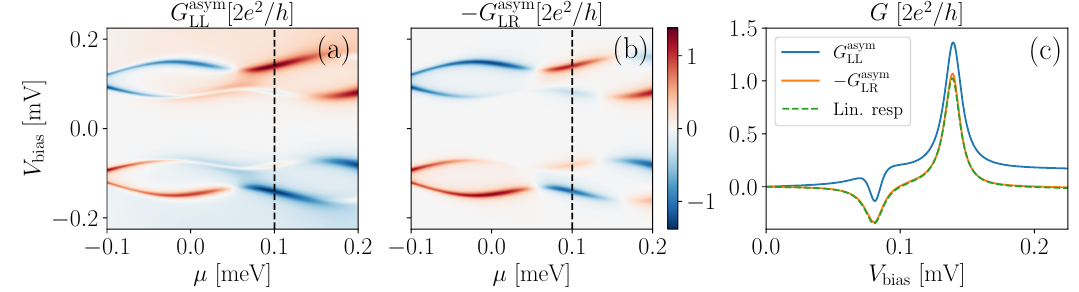
Figure 9: Anti-symmetric components of the (a) local conductance and (b) nonlocal conductance as a function of chemical potential and bias voltage. In panel (c) we show a one-dimensional cut of this data at fixed chemical potential (black dashed